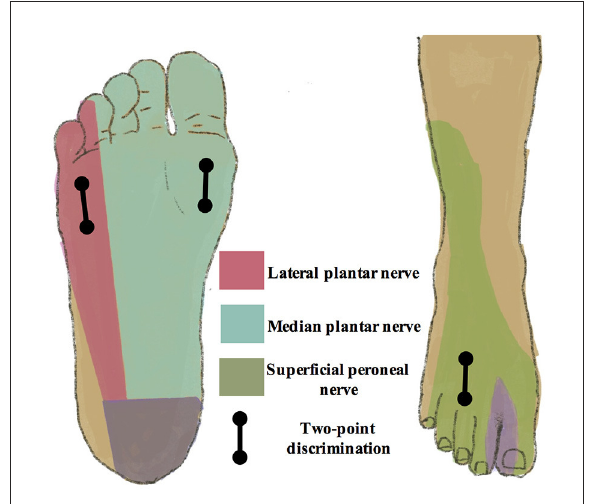
FIGURE2 Sensory territories of peripheral nerves in the lower extremities. The two-point discrimination test is performed in the sensory territories of the superficial peroneal nerve, medial, and lateral plantar nerves, including the anterior dorsum of the foot, and medial and lateral anterior plantar